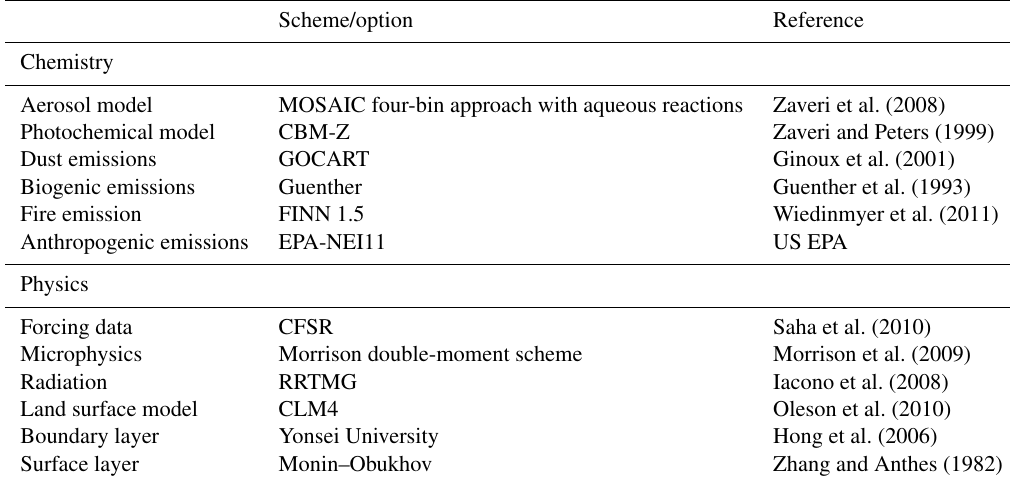
Table 1. Listing of WRF-Chem specifications. NOCHEM is identical to CNT except without the chemistry options.